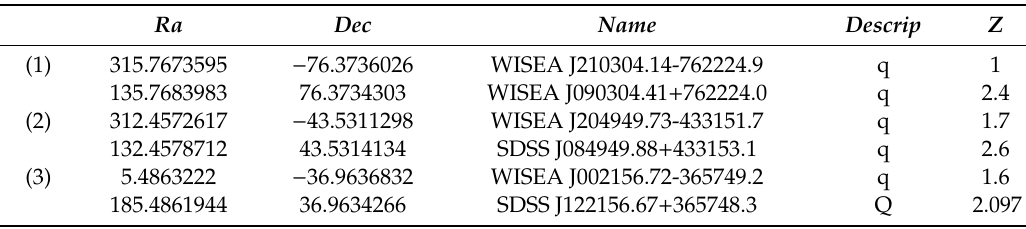
Table A16. Pairs of opposite quasars from the Milliquas 6.3 catalog for the cosmic mirror e ff ect— alternative approach. Accuracy is of 0.0005 ◦ for ra and dec and z / 2 for redshift z . Descrip column is the classification of object, see